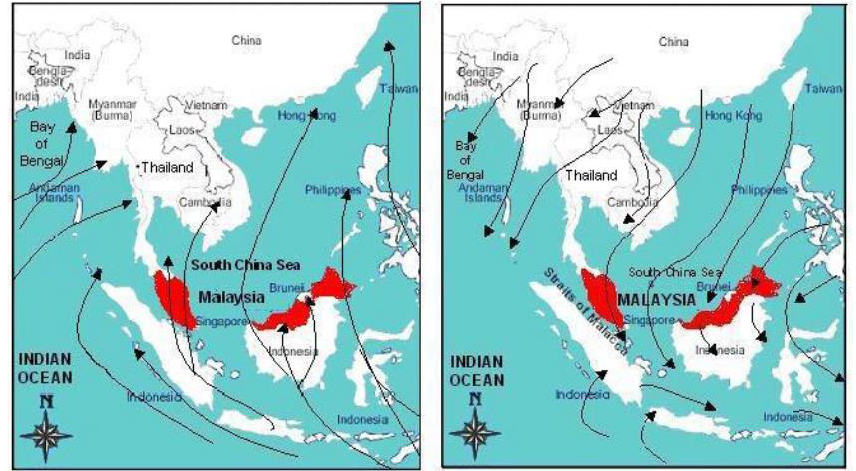
Fig. 1. Southwest (left) and northeast (right) monsoons around South-East Asia